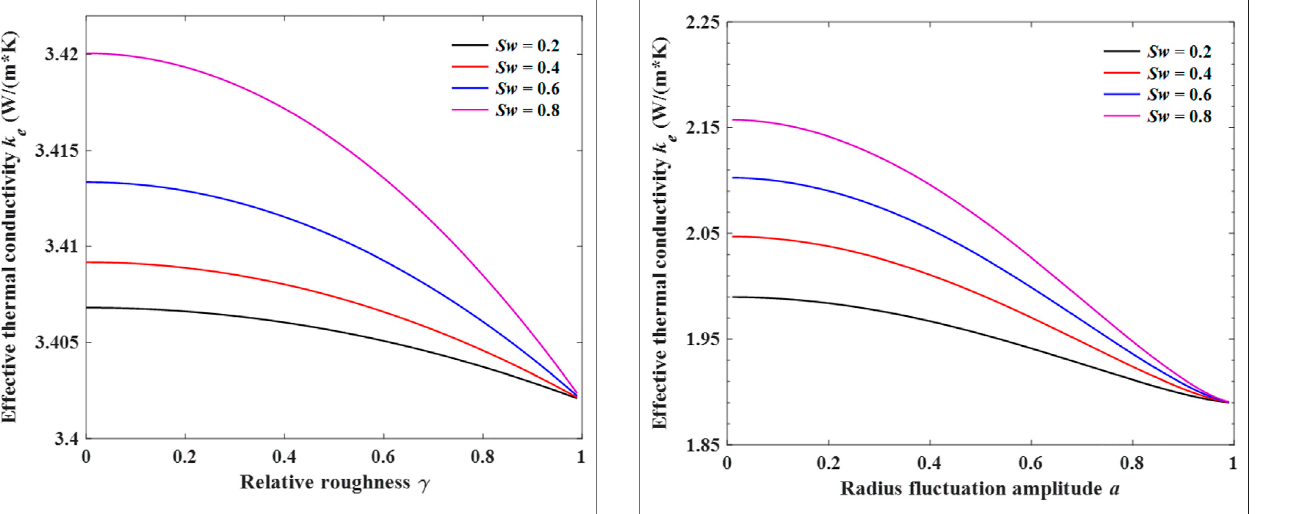
FIGURE 10 | The effect of radius fl uctuation amplitude on the